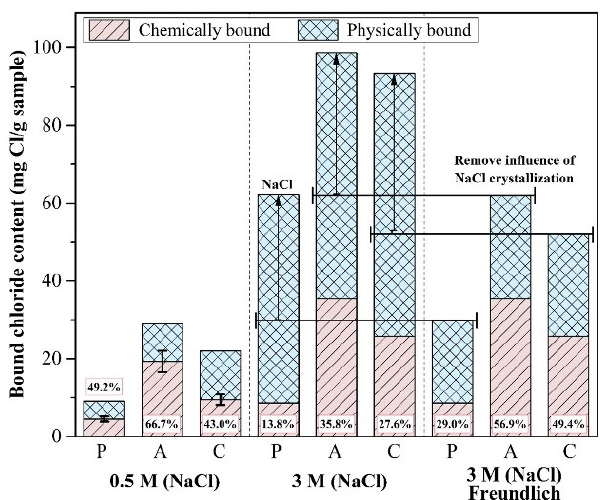
Figure 6. Calculated chemically bound chloride content and its composition regarding the total bound chloride content.